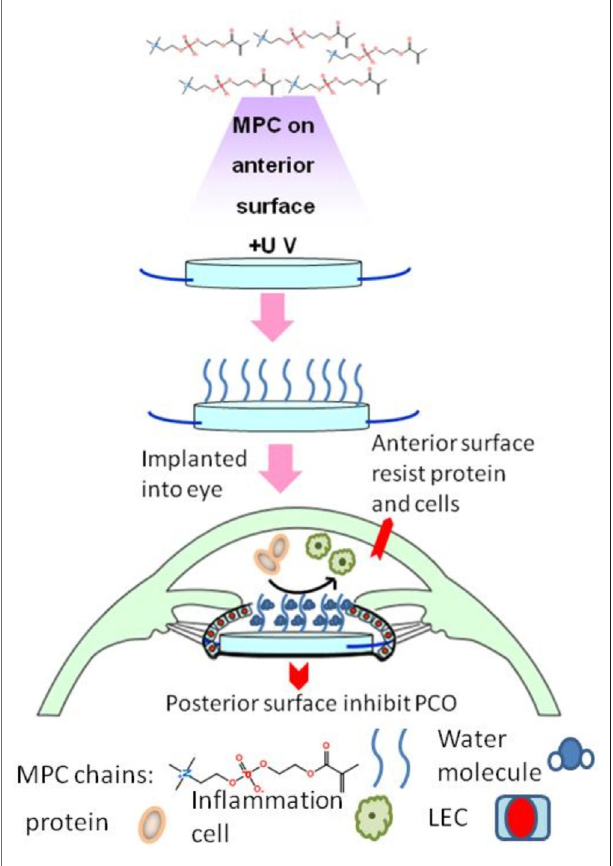
FIGURE 4 | The modi fi ed IOL from Huang et al. (2017), with the permission of Elsevier. MPC, 2-methacryloyloxyethyl